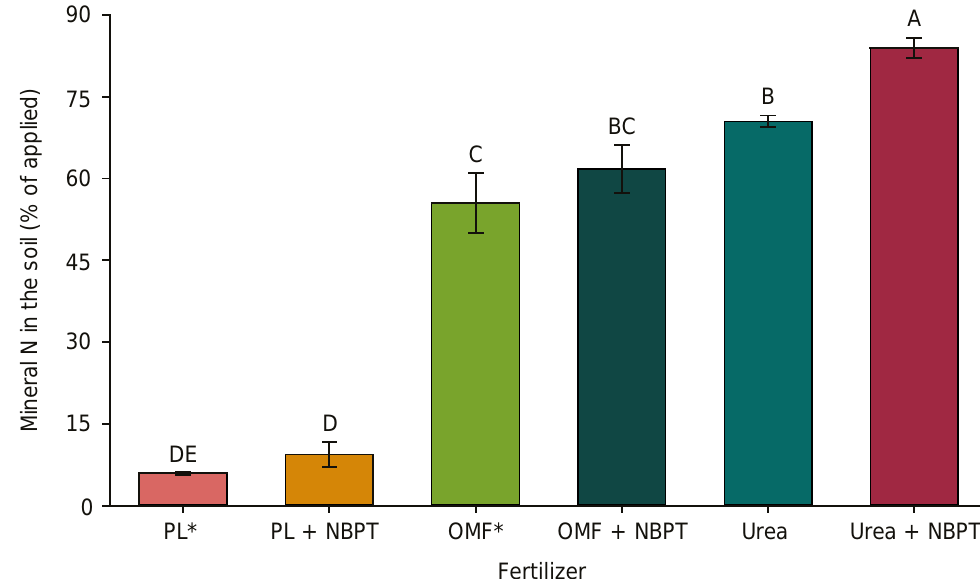
FertilizerPL* PL + Figure 4. Percentage of mineral N (NH + 4 + NO − 3 ) in the soil in relation to the total nitrogen applied (200 mg kg -1 N) at 56 days after fertilizer application in the presence or absence of N-(n-butyl) thiophosphoric triamide (NBPT). Uppercase letters compare NH + 4 values in the soil. Treatments followed by the same letter do not differ by the Tukey test (p<0.05). Bars in the columns indicate the average test error. PL*: Poultry litter; OMF*: organomineral fertilizer.